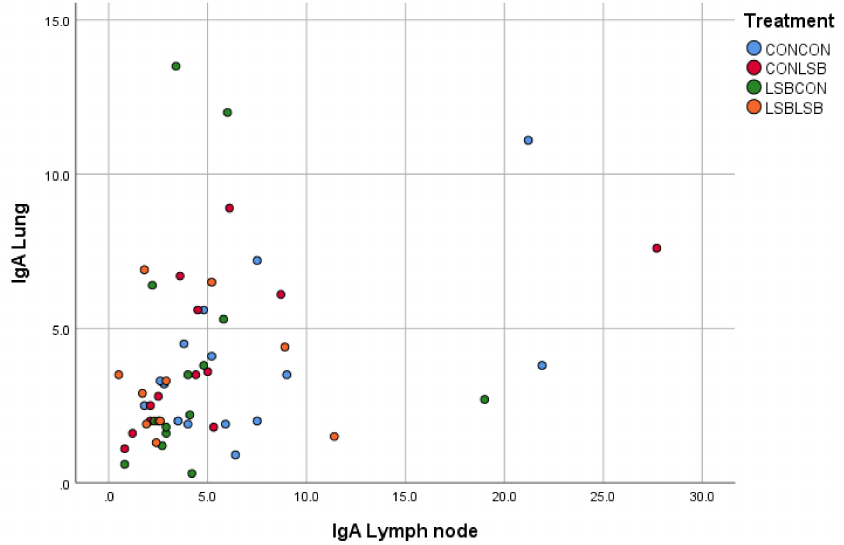
Figure 3. Correlation between the number of IgA producing cells in the lymph node and in the